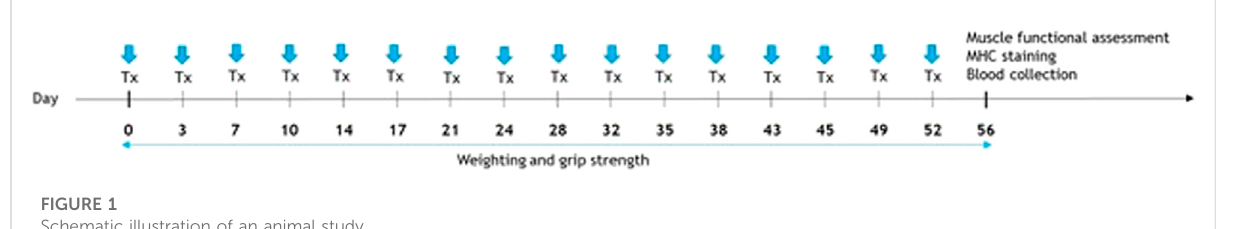
FIGURE 1 Schematic illustration of an animal